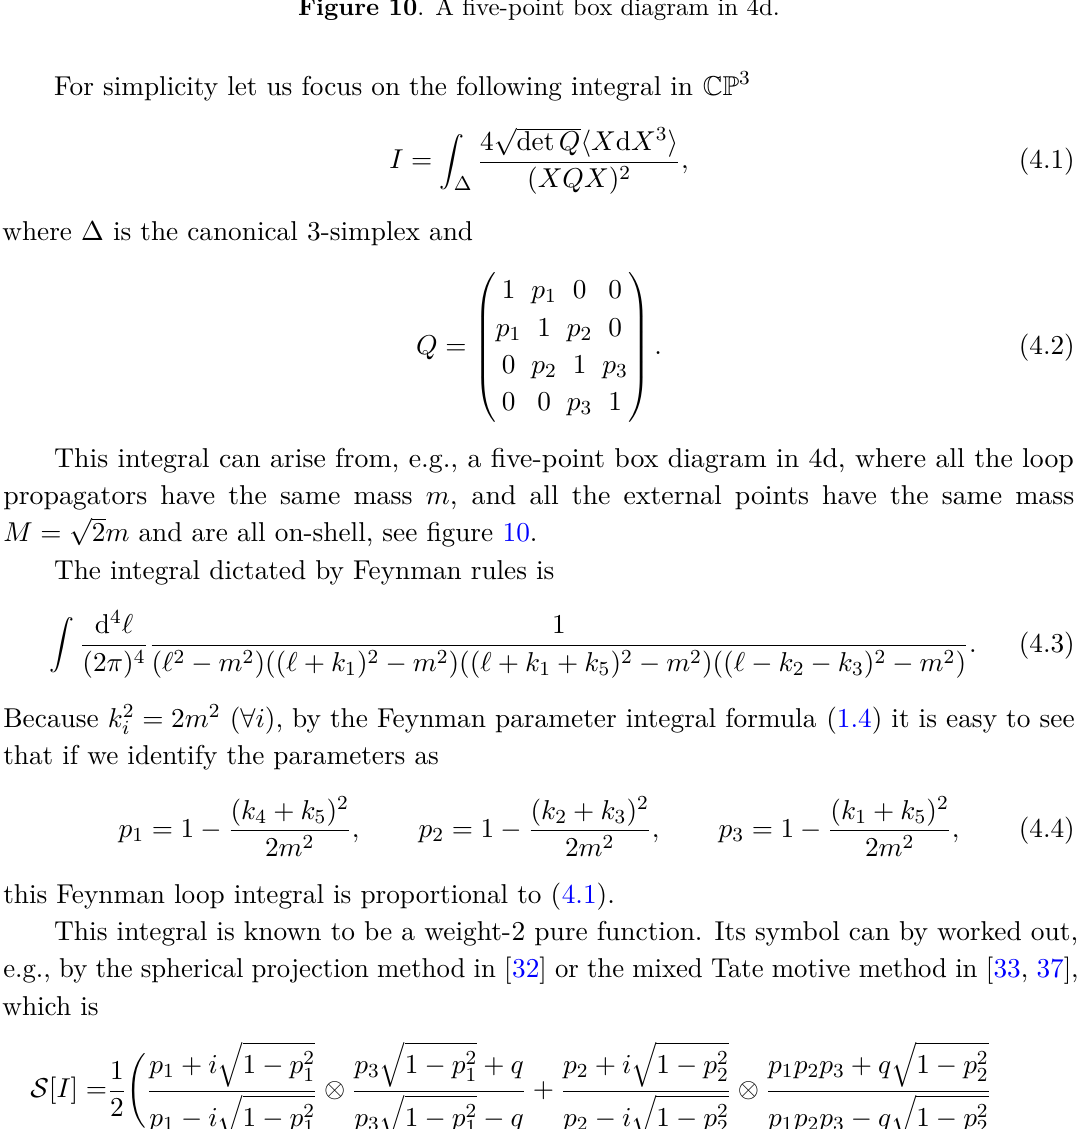
Figure 10 . A five-point box diagram in